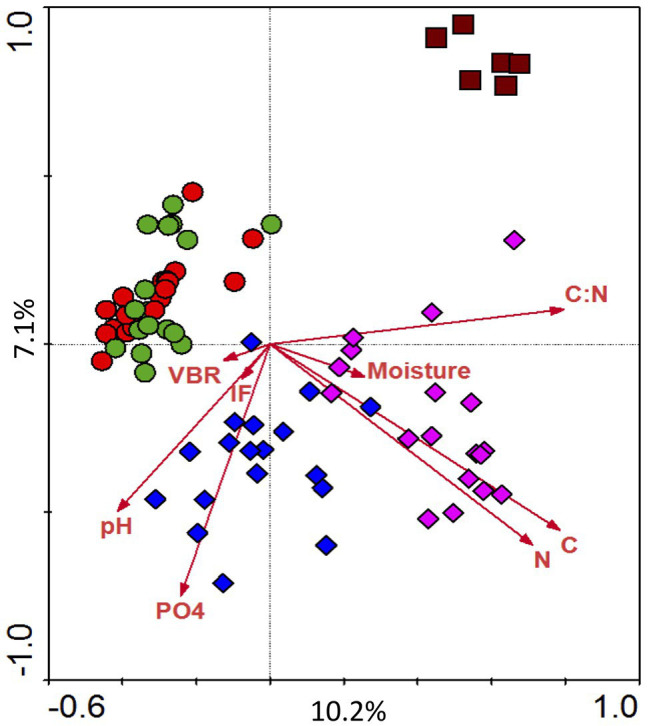
Diversity of bacterial community as determined using Terminal Restriction Fragment Length Polymorphisms (T-RFLPs). Ordination completed using canonical correspondence analysis (CCA), constrained by various environmental parameters (carbon, nitrogen, phosphate, moisture, C:N ratio). The treatments of soil samples were represented by colors and shapes. Red circle, T1; green circle, T4; blue square, T7; purple square, T8; dark red square, SF2.